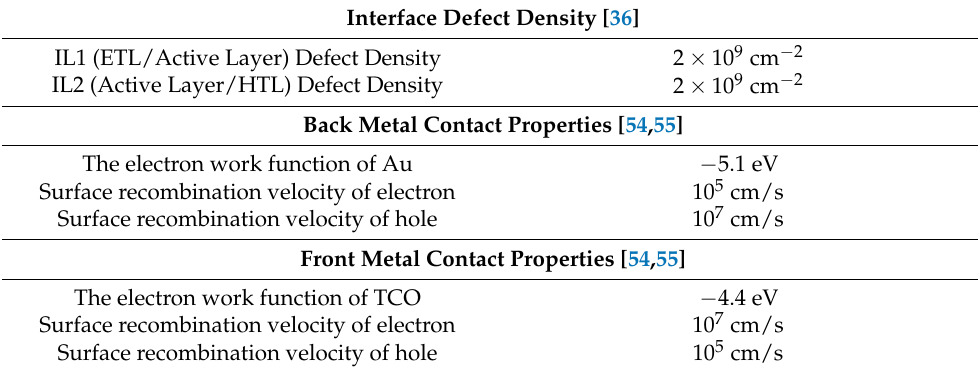
Table 2. Device parameters set in the